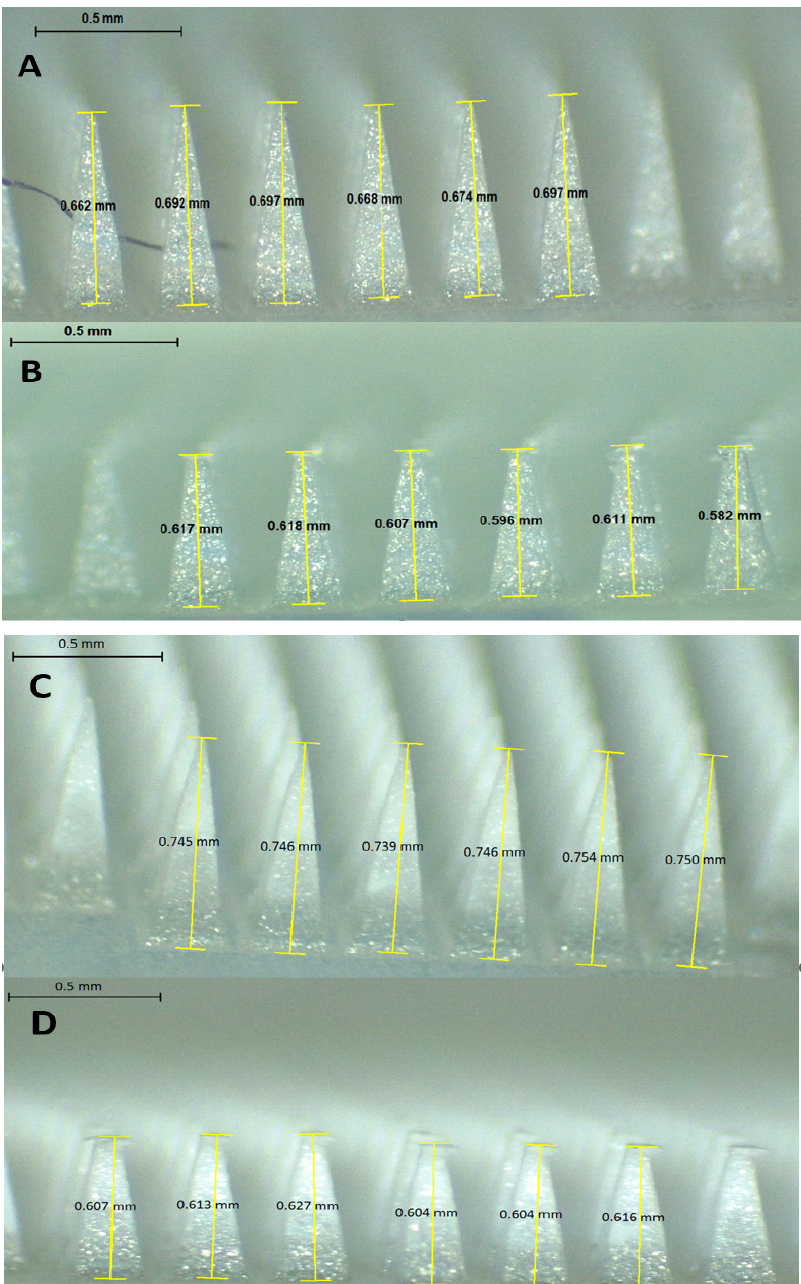
Figure 5. Mechanical strength determination of DMNs by a texture analyzer by applying a force of 32 N for 30 s (mean ± SD, n = 6). ( A ) Heights of DFS-NS-DMNs before compression; ( B ) Heights of DFS-NS-DMNs after compression; ( C ) Heights of DFS-DMNs before compression; ( D ) Heights of DFS-DMNs after